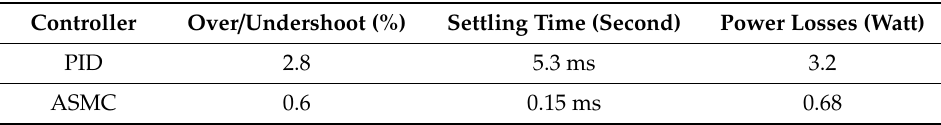
Figure 7. PID & ASMC basd on P&O MPPT ( a ) Profile of the PV panel voltage ( b ) Tracking response ( c ) Profile of the PV power extraction ( d ) IAE. Table 3. Performance characteristics of the conventional controller and the proposed ASMC controller based on P&O